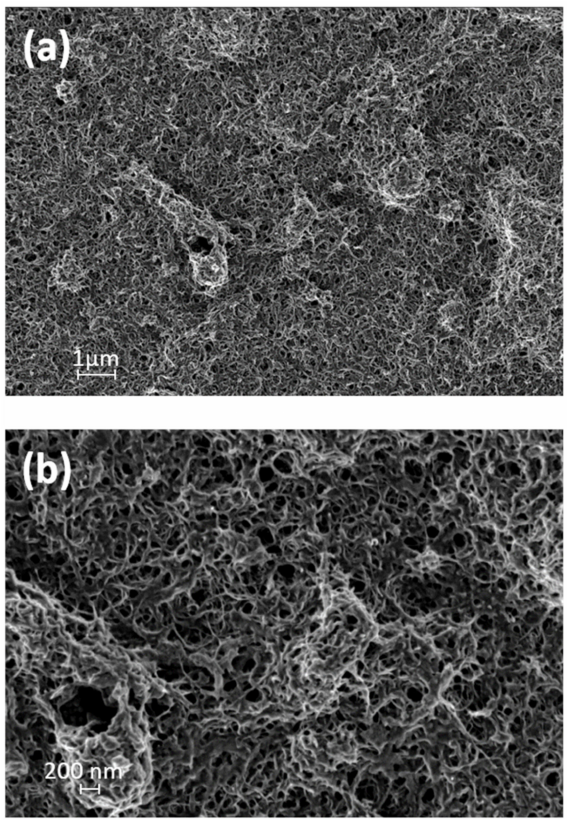
Figure 4. High-resolution scanning electron microscopy (HRSEM) images of PANI / CNT Bucky